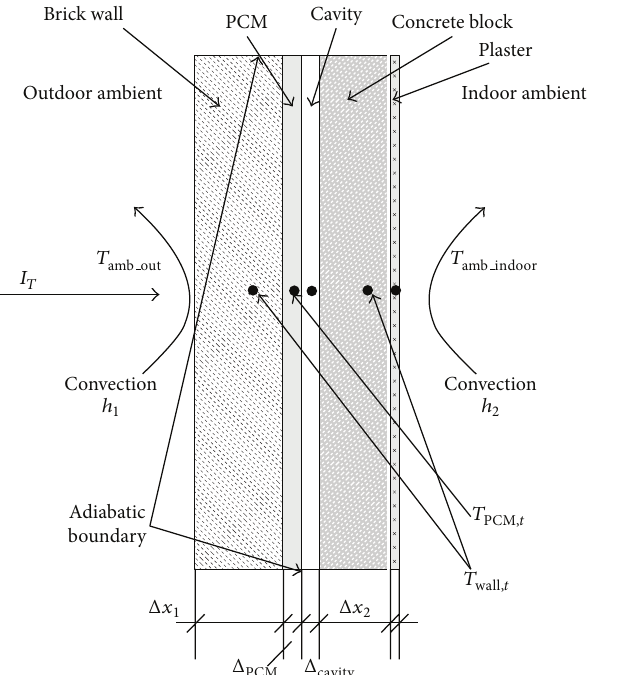
Figure 5: Test wall